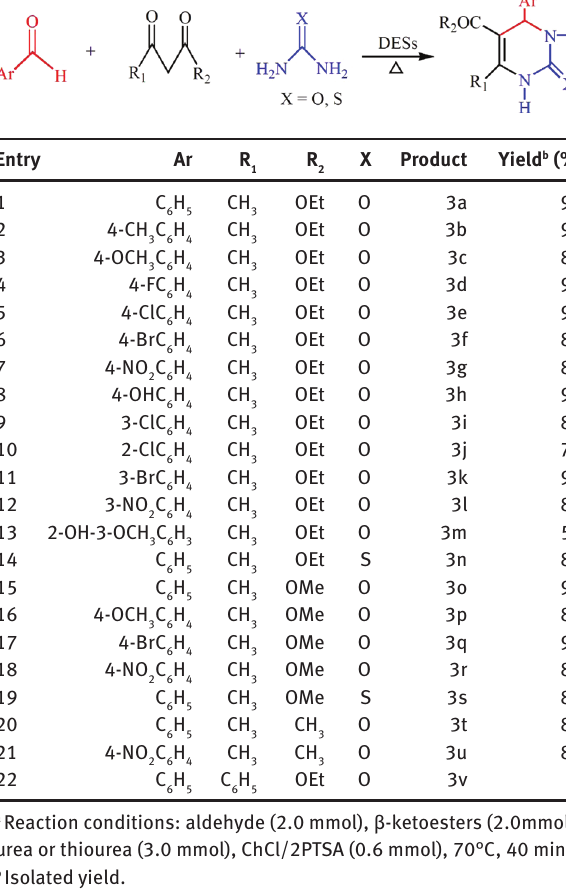
Table 2. The melting points, 1 H NMR, and 13 C NMR of the